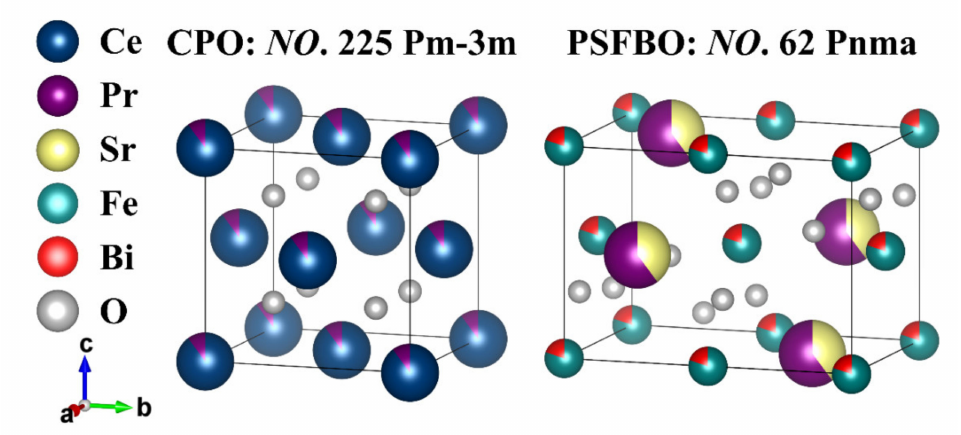
Figure 2. Crystal structure models of 60CPO-40PSF 1 − x B x